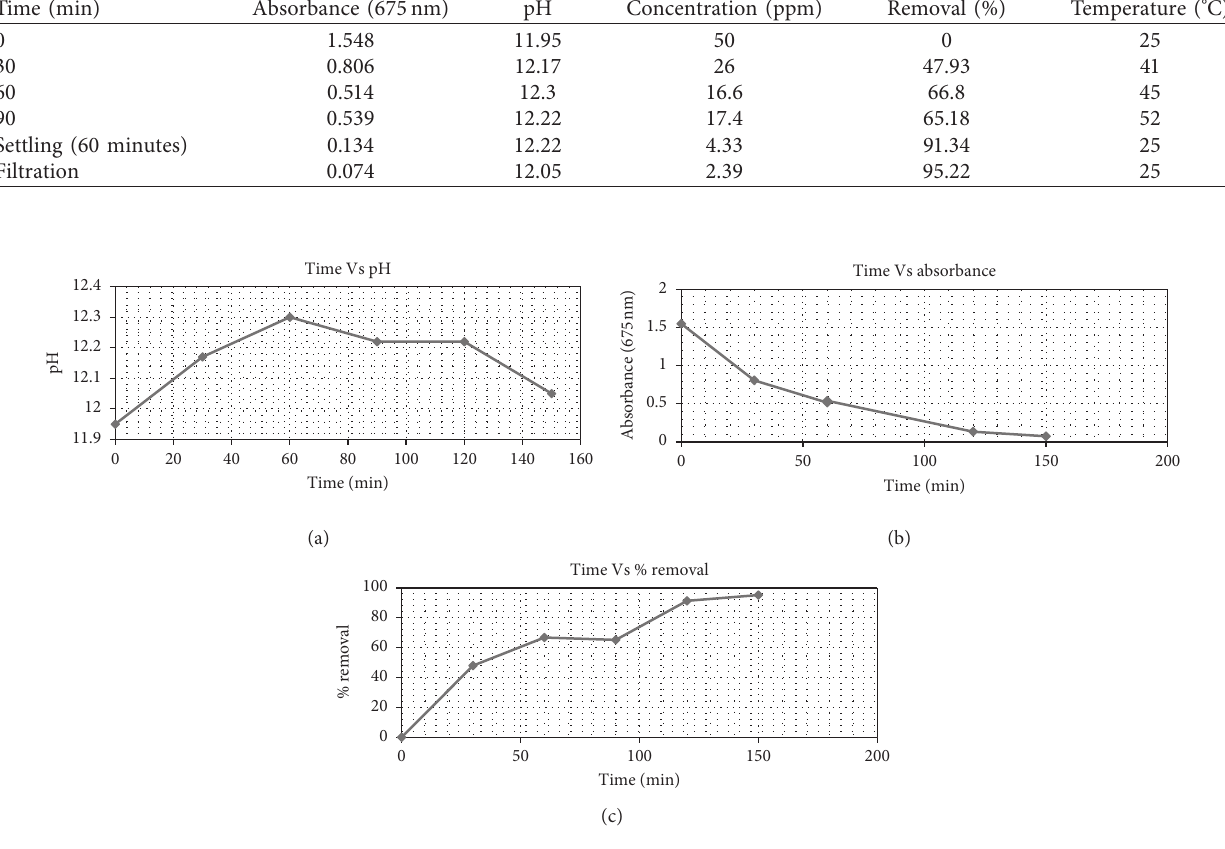
Figure 6: (a) Plot of pH with respect to time over 160min period. (b) Plot of absorbance with respect to time over 200min period. (c) Plot of percent removal with respect to time over 200min